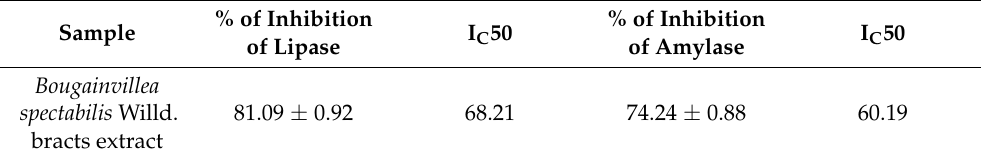
Table 3. Lipase and amylase inhibition assay of Bougainvillea spectabilis Willd. bracts